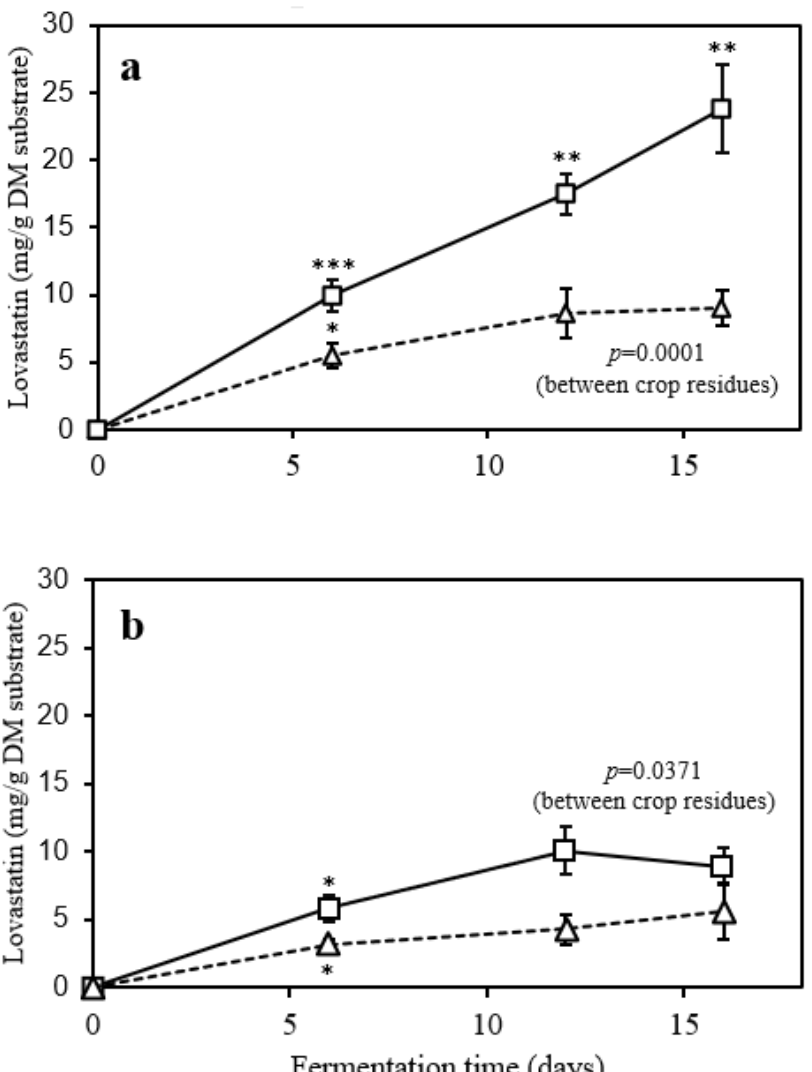
Figure 1. Lovastatin production by SSF: ( a ) A. terreus CDBB H ‐ 194 and ( b ) A. terreus CDBB H ‐ 1976 with two crop residues as substrates. Keys: , oat straw; , wheat bran. Data represent the mean ± standard deviation. Asterisks in lines indicate significant differences from repeated measures as determined by the procedure of Tukey (* p < 0.05; ** p < 0.01; *** p < 0.0001).